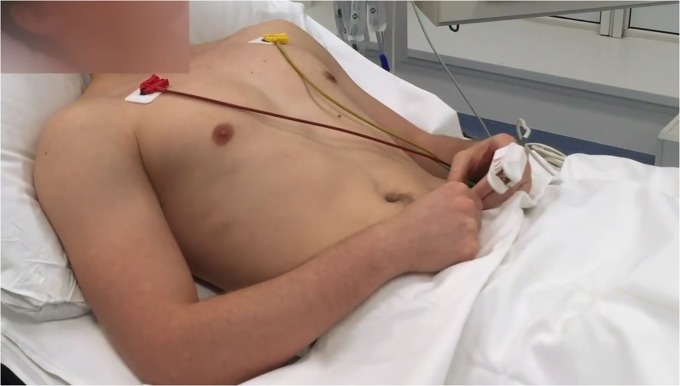
Still example of one of the videos used in the questionnaire.